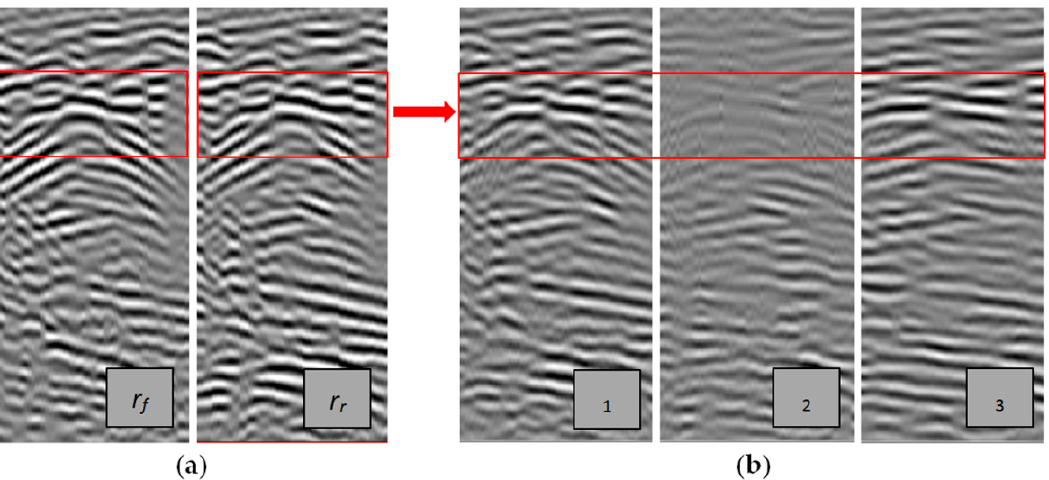
Figure 10. The influence of latency correction on these profile pairs. ( a ) r f —6 and r r —19 pairs; ( b ) subtracted selected GPR profile sections: (1) latency under-corrected, (2) with the corrected latency, (3) with the latency over-corrected by two.